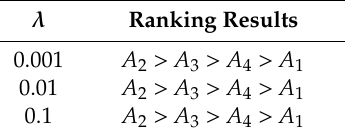
Table 10. The evaluation results a ff ected by di ff erent λ